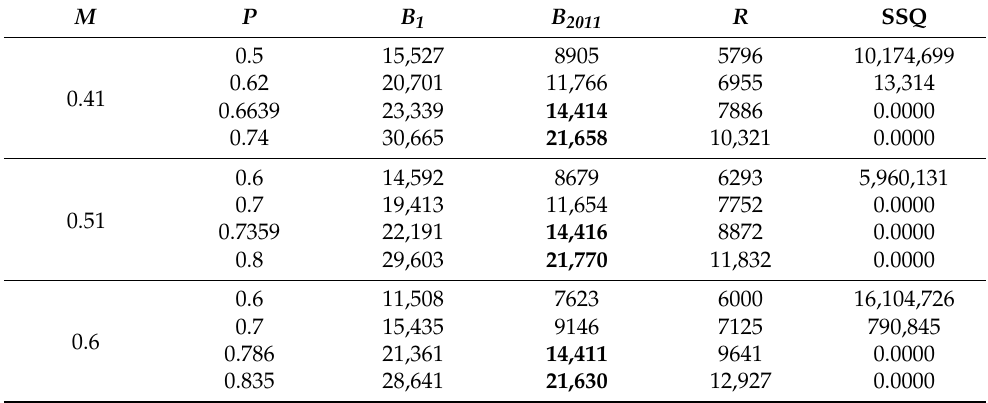
Table 2. Acceptable solutions of SRA of bigeye croaker M. megalops for three M values and information on biomass in early 2011. Bold numbers are approximations to media and upper limit of C.I. 95% of B 2011 .